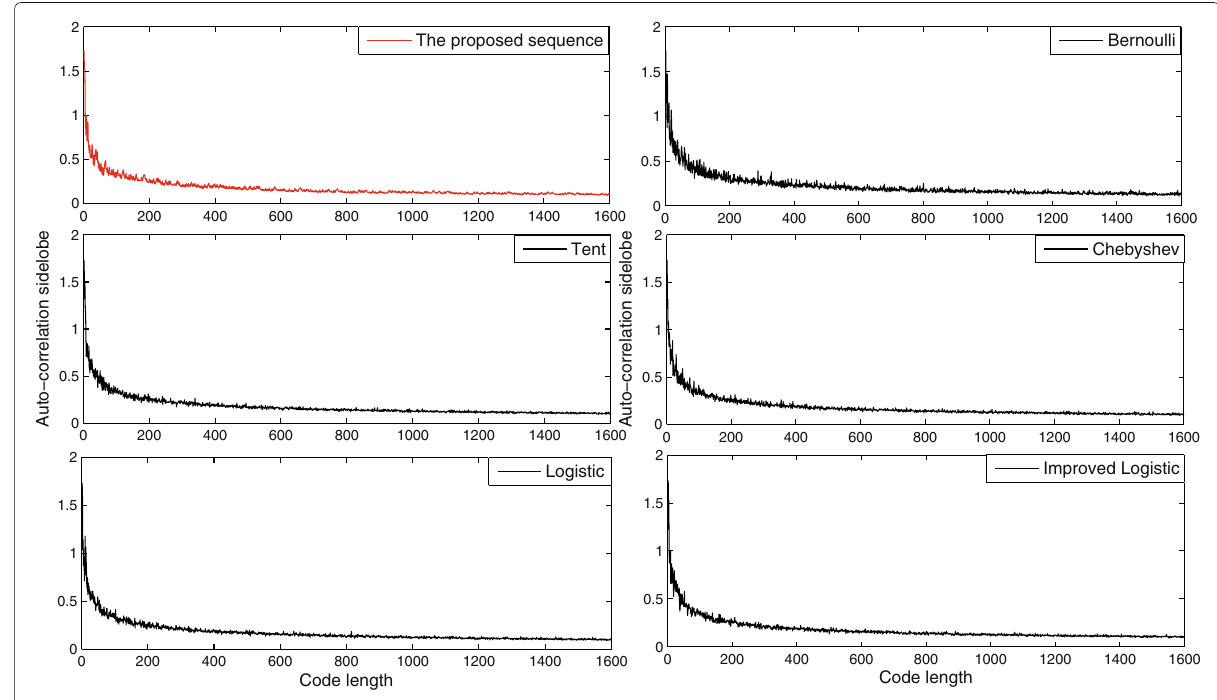
Fig. 5 Auto-correlation sidelobe of six chaotic sequences